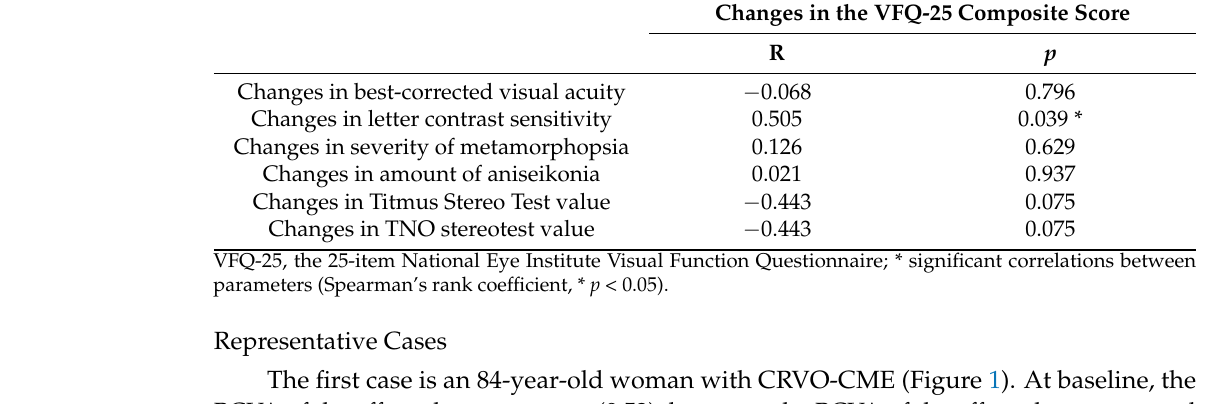
Table 5. Simple regression analysis between changes in the VFQ-25 composite score and changes in several visual functions.